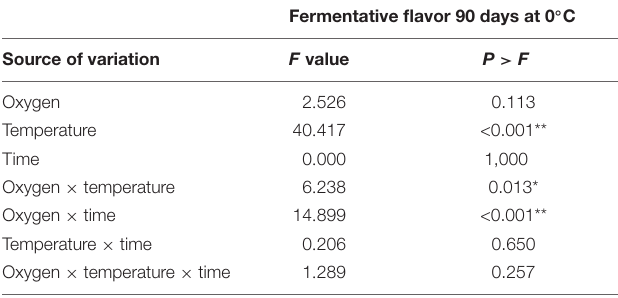
TABLE 3 | Individual effect and interactions of conditioning treatments: oxygen concentration (0.5 and 21 kPa), temperature (0 and 5 ◦ C), and conditioning time (15 and 30 days) in ‘Fuji’ apples for fermentative flavor stored during 90 days at 0 ◦ C.